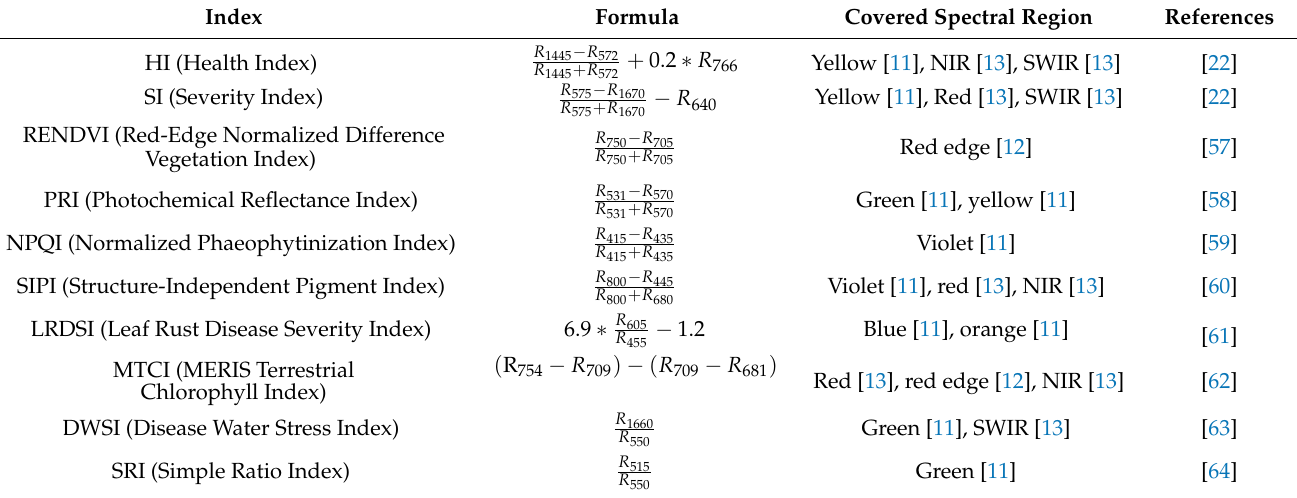
Table 3. Indices selected for this study.